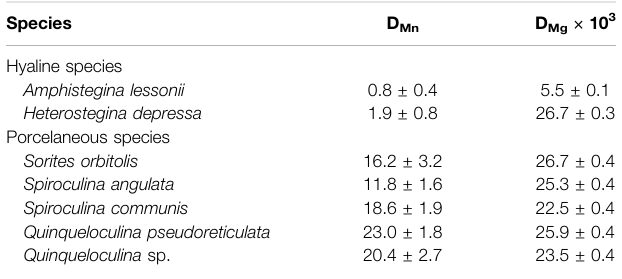
TABLE4| MnandMgpartitioningwithpropagatingstandarddeviationforspecies collected from Burgers ’ Zoo aquarium. Species D Mn Hyaline species Amphistegina